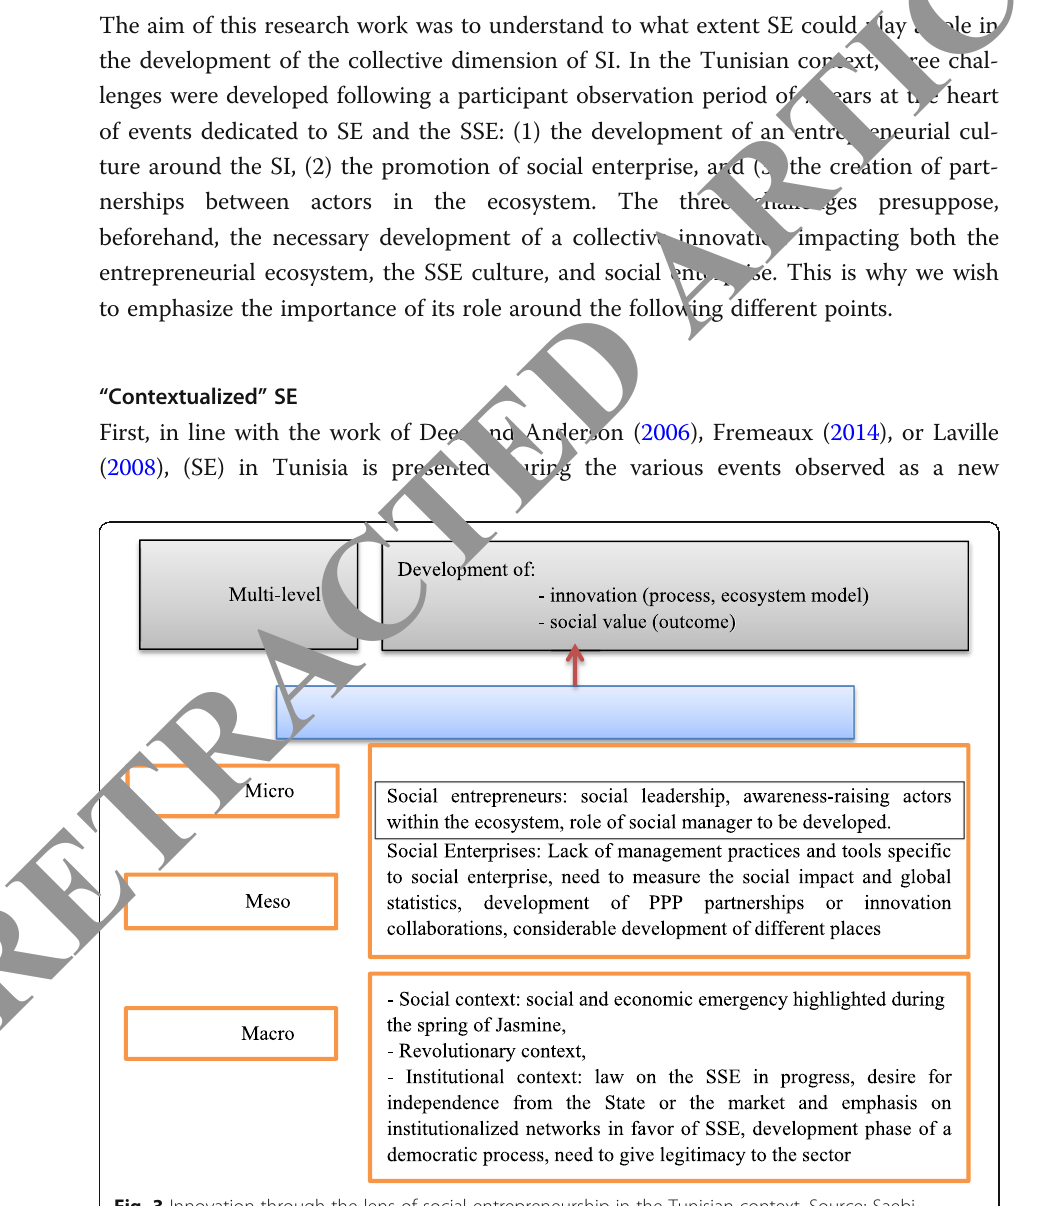
Fig. 3 Innovation through the lens of social entrepreneurship in the Tunisian context. Source: Saebi et al.